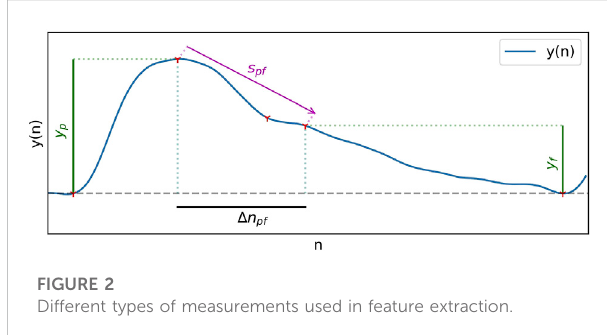
FIGURE 2 Different types of measurements used in feature